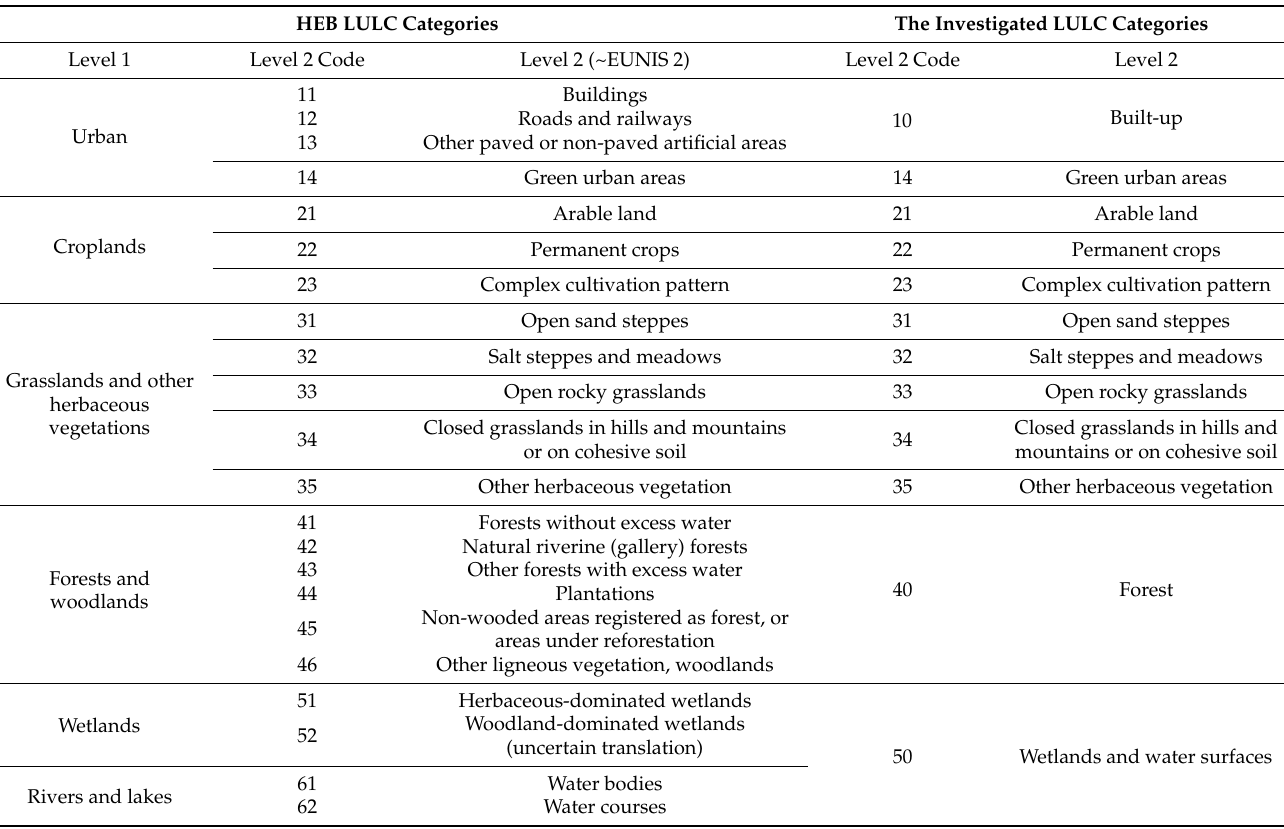
Table A1. The LULC categories of the Hungarian Ecosystem Basemap, and the investigated LULC categories.